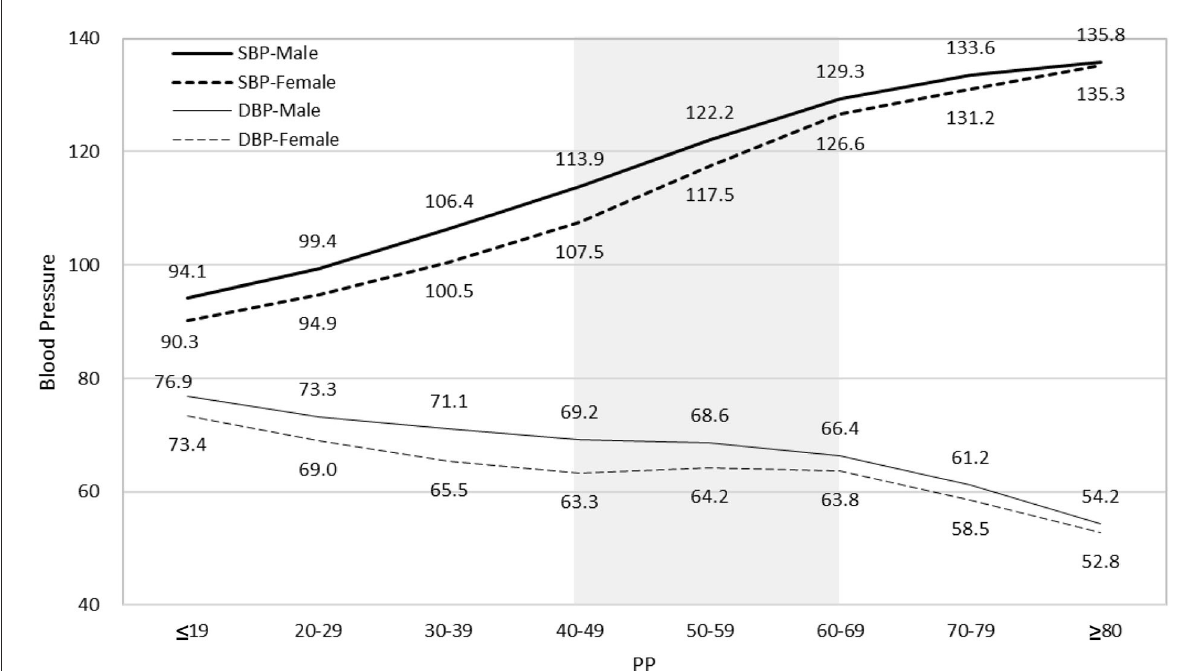
FIGURE2 Relationship of PP with SBP and DBP for both sexes. PP increase always results from both SBP increase and DBP decrease except in female subjects with PP 40–70 mmHg (shadow area). Mean DBP of female subjects does not decrease as PP increases from 40 mmHg to 70 mmHg. PP indicates pulse pressure; SBP, systolic blood pressure; DBP, diastolic blood